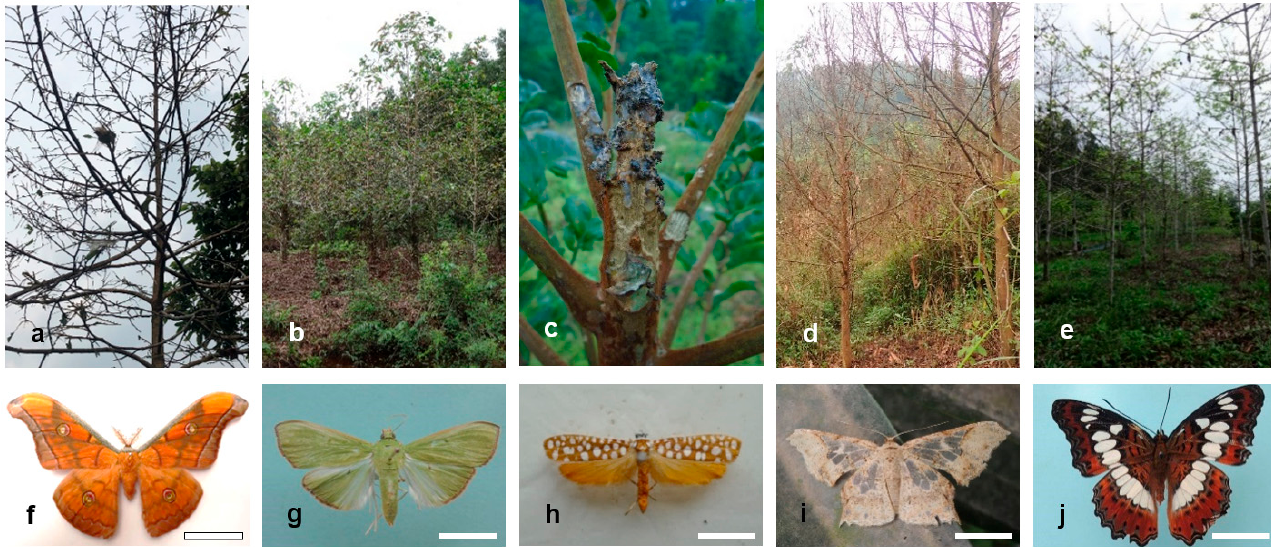
Figure 3. Emerging Lepidoptera threats to forest plantations in Vietnam. ( a – e ) damaged to trees from folivores; ( f – j ) adults. ( a , f ) Antheraea frithi damage in Dipterocarpus alatus ; ( b , g ) Arthroschista hilaralis damage in Neolamarckia cadamba ; ( c , h ) Atteva fabriciella damage in Ailanthus triphysa ; ( d , j ) Krananda semihyalina damages in Cinnamomum cassia ; ( e , l ) Moduza procris damage in Nauclea orientalis . Scale bar: f = 3.0 cm; g = 1.5 cm; h = 0.5 cm; i = 1.8 cm; j = 2.0 cm.